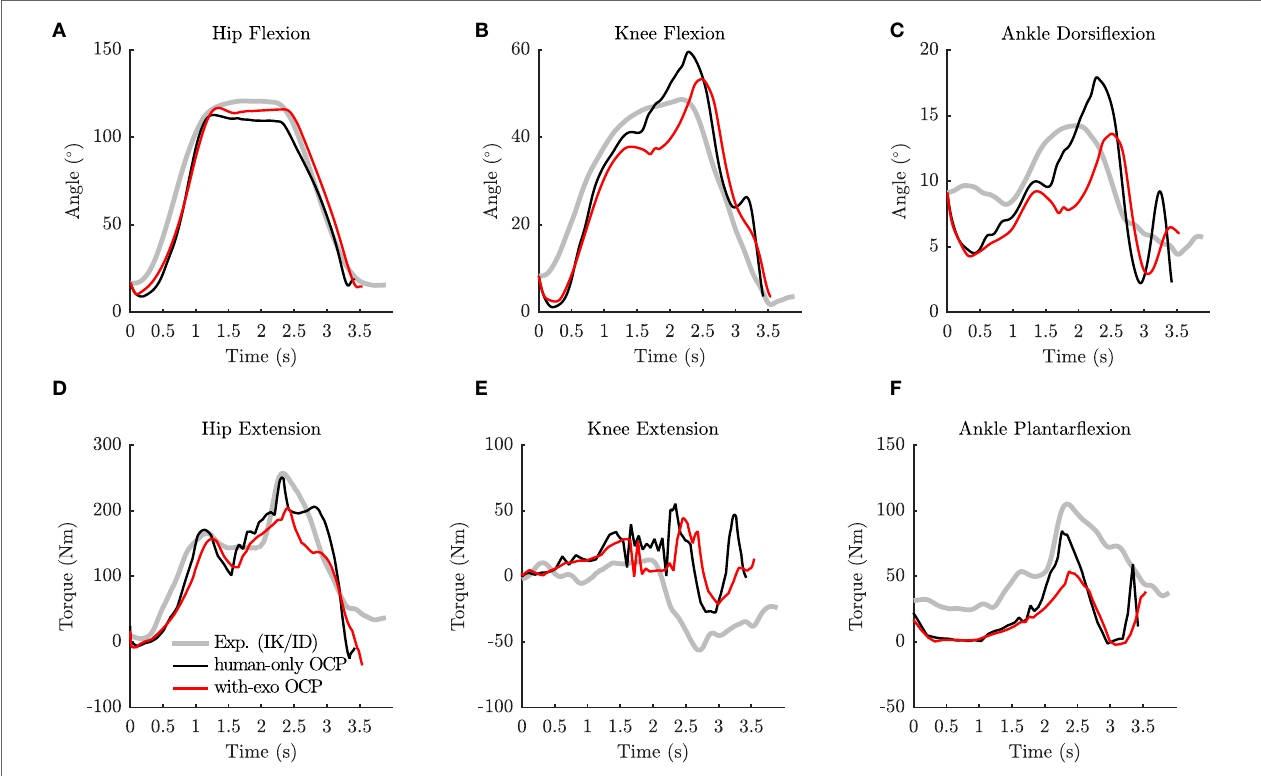
FIgURe 5 | The joint angles of the hip (a) , knee (b) , and ankle (C) from the inverse-kinematics analysis of the experimental subject, the human-only OCP, and the with-exo OCP are shown in the top row. The corresponding joint torques of the hip (d) , knee (e) , and ankle (F) from the inverse-dynamics analysis of the experimental subject, the human-only OCP, and the with-exo OCP are shown in the bottom